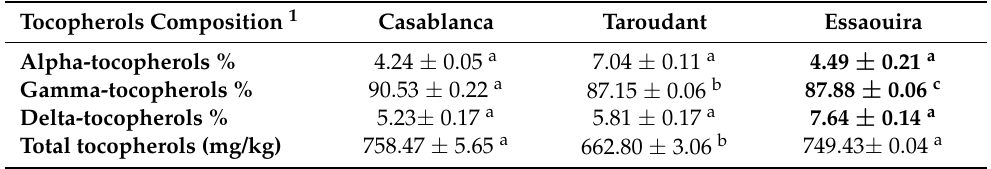
Table 4. Comparison of tocopherol concentration (%) of argan oil from argan trees grown on a plantation (Casablanca: AOC) and in two natural forest stands (Taroudant: AOT and Essaouira: AOE). Tocopherols Composition 1 Casablanca Taroudant Essaouira Alpha-tocopherols % Gamma-tocopherols % Delta-tocopherols % Total tocopherols (mg/kg) 749.43 ± 0.04 a 1 Mean values ± standard deviation ( n = 2). Values in the same column with different letters are significantly different at p <0.05, according to the Bonferroni